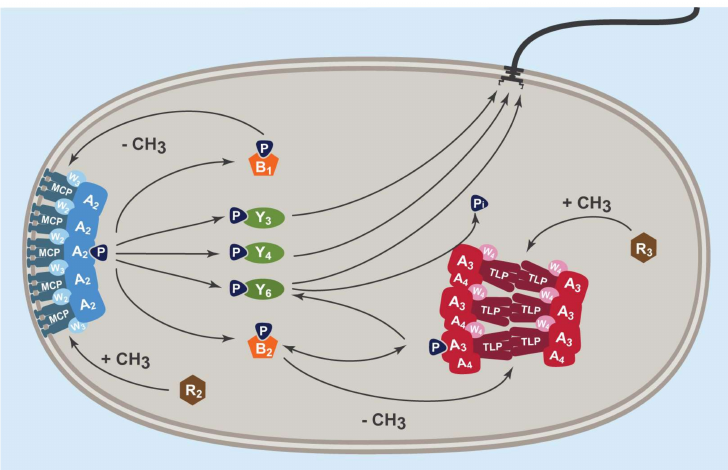
Figure 1. R. sphaeroides chemosensory proteins and CheA and CheW homologues localise to two areas in the cell, forming membrane-associated clusters (MCPs, CheA 2 , CheW 2 , and CheW 3 ) and cytoplasmic clusters (Tlps, CheA 3 , CheA 4 , and CheW 4 ). CheR 2 also localises to the membrane cluster and CheR 3 to the cytoplasmic cluster. CheB and CheY homologues are di ff use within the cell. Phosphotransfer shown is known from in vitro studies [12]. Methyltransfer shown is hypothesised based on CheR localisation and cheB gene positions (CheB 1 is encoded on the membrane cluster operon and CheB 2 on the cytoplasmic cluster